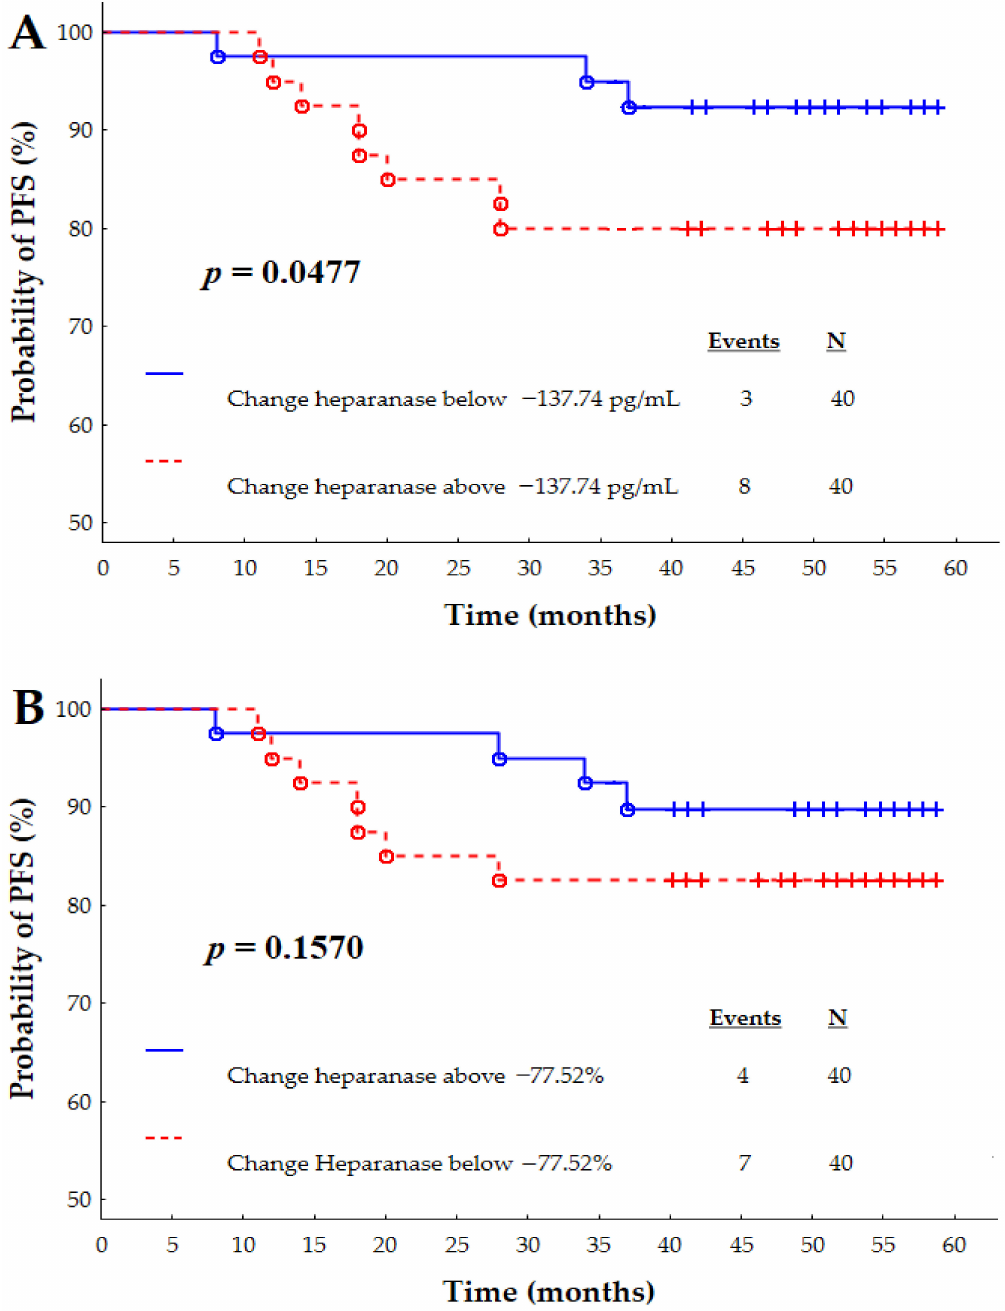
Figure 3. Kaplan-Meier survival curves depending on numerical ( A ) and percentage ( B ) changes of heparanase con- centrations. The numerical and percentage changes cut-offs for heparanase were established at − 137.74 pg/mL and − 77.52%,